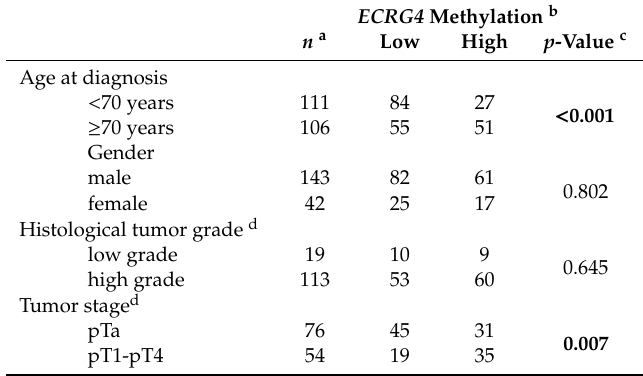
Table 3. Clinico-pathological parameters in relation to ECRG4 methylation in training cohort #2.